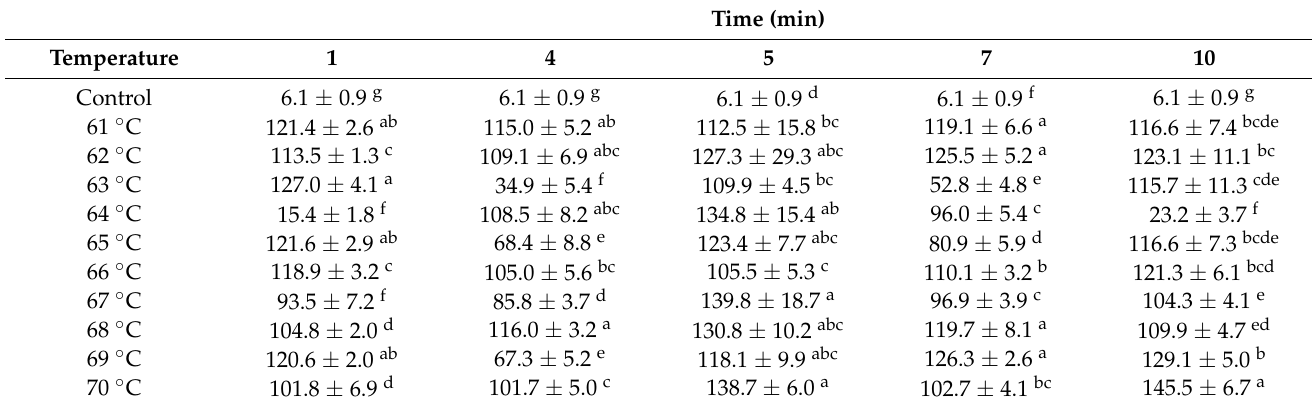
Table 2. Effect of heat treatment with varying time on LEY protein particle size. Time